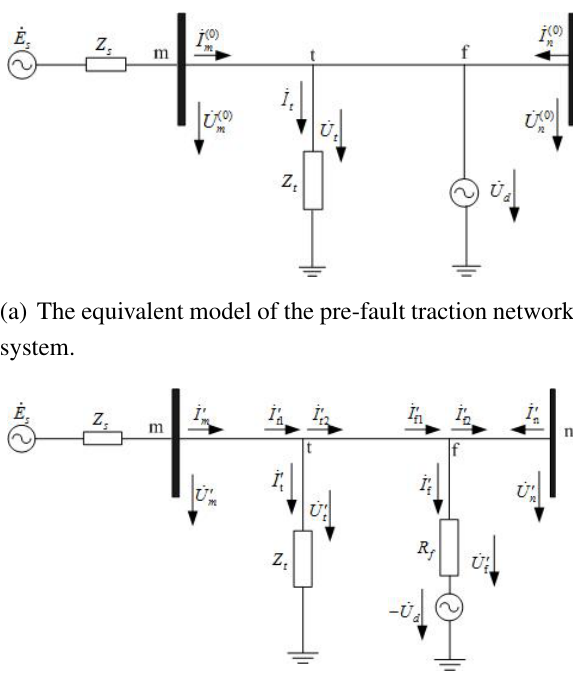
Figure 5. The equivalent model of faulted traction network